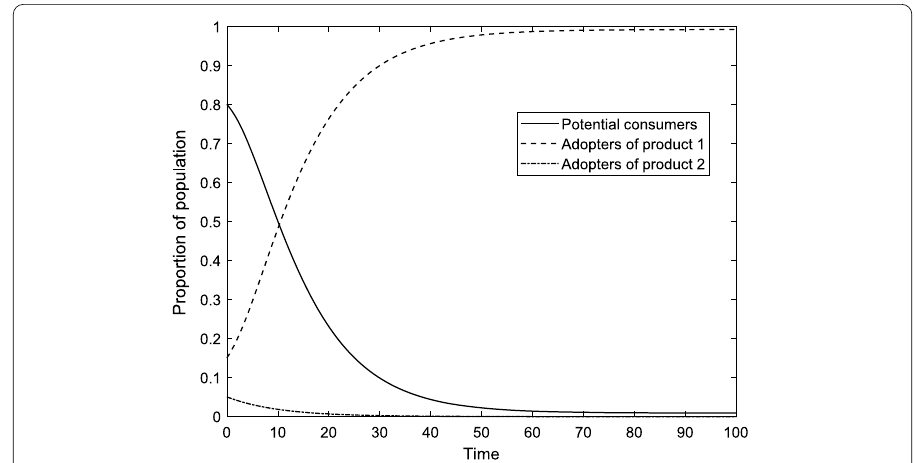
Figure 3 Only product 1 persistently diffuses without considering advertising strategy